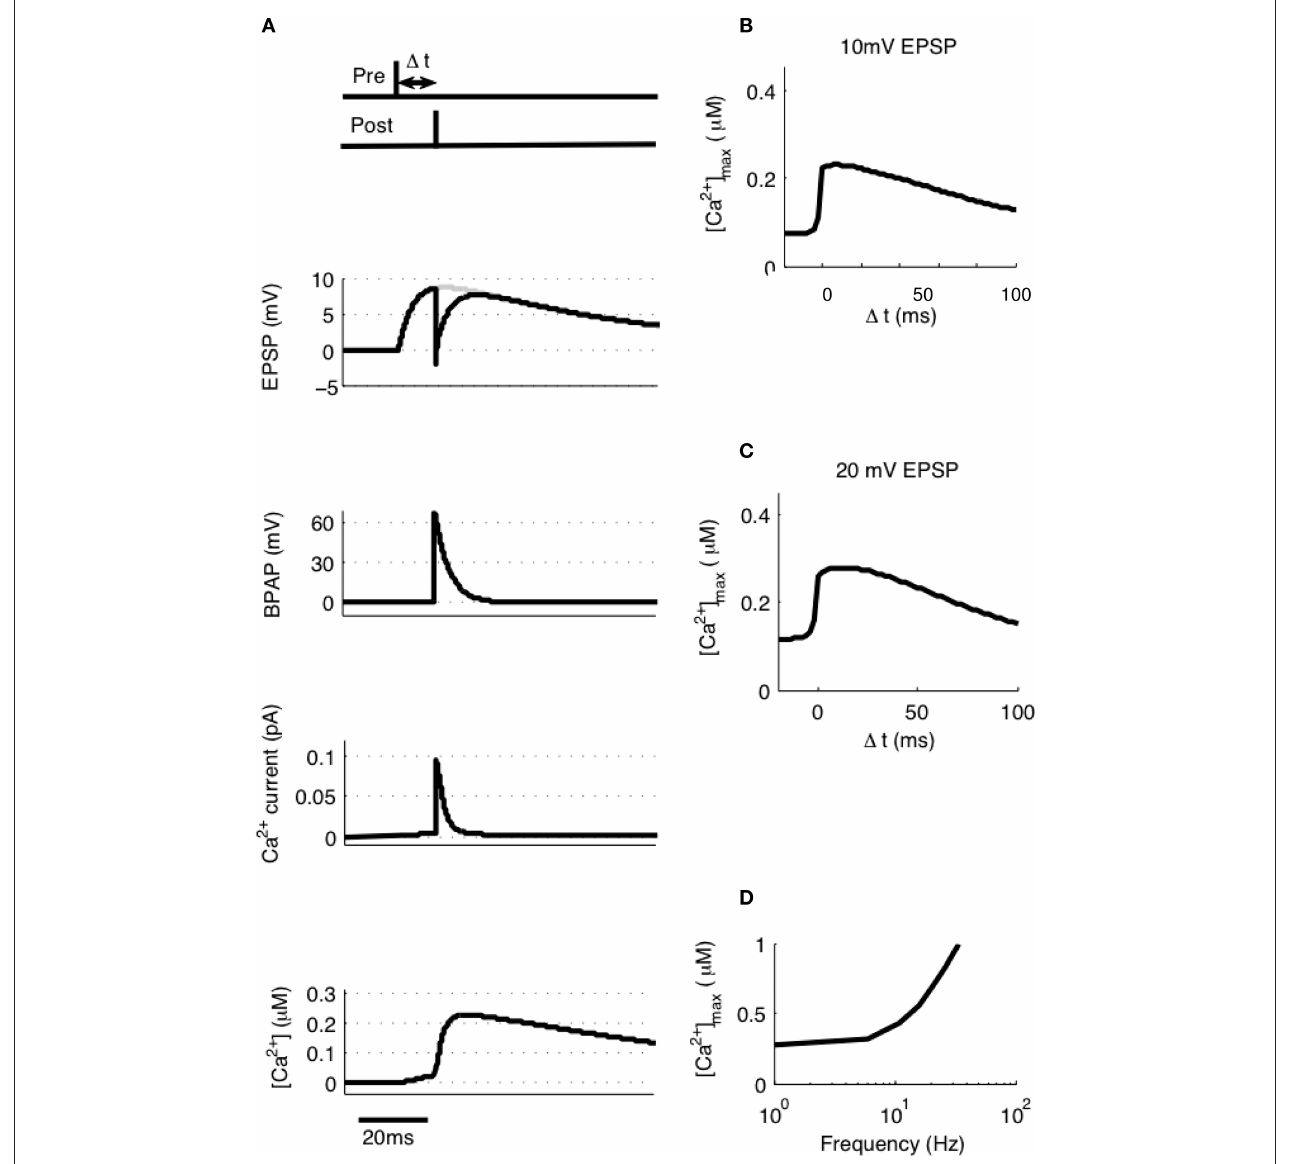
Figure 3 | [Ca 2 + ] dynamics in response to paired pre- and post-synaptic spikes. (A) The model calculates [Ca 2 + ] within a spine from the membrane potential resulting from a pair of pre- and post-synaptic spikes. Gray line shows